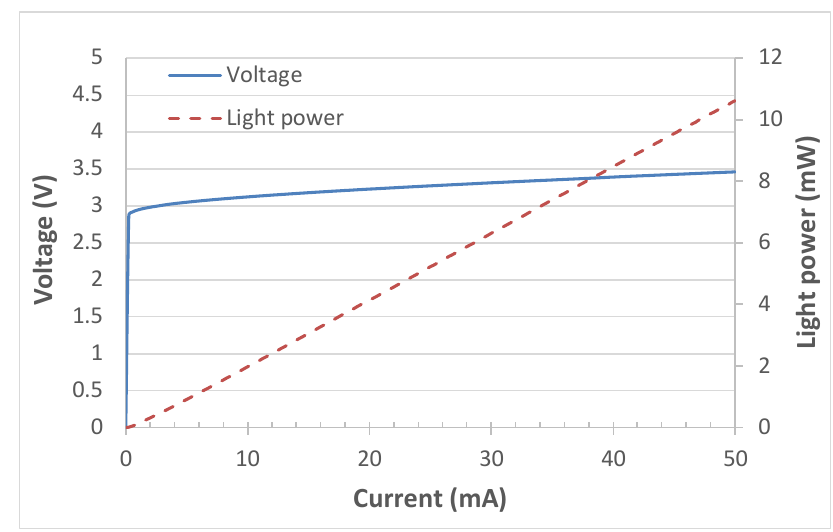
Figure 3. V–I–L characteristics of the UV LED.